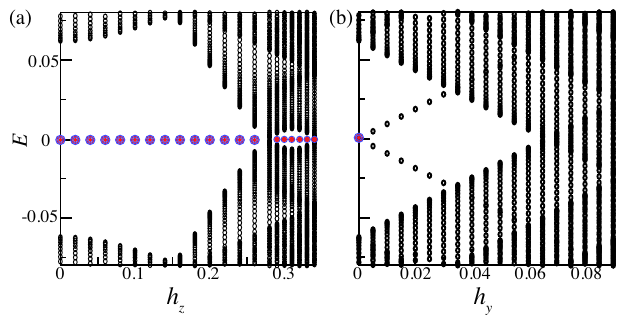
FIG. 9. (a) Energy spectrum of the 2D s -wave superconductor with an embedded mirror RALD as a function of the Zeeman field h z . The SC gap closes and reopens at h c z ≃ 0 . 28 with the concomitant reduction in the number of MZMs from four to two (red and blue dots), signaling the transition of the TSC in class BDI with the reduction of the topological invariant from Z ¼ 2 to Z ¼ 1 . (b) The same as in (a) and with the same parameters, but the Zeeman field h y is perpendicular to the mirror RALD. The zero modes split immediately as h y is turned on, as the TSC becomes a topologically trivial